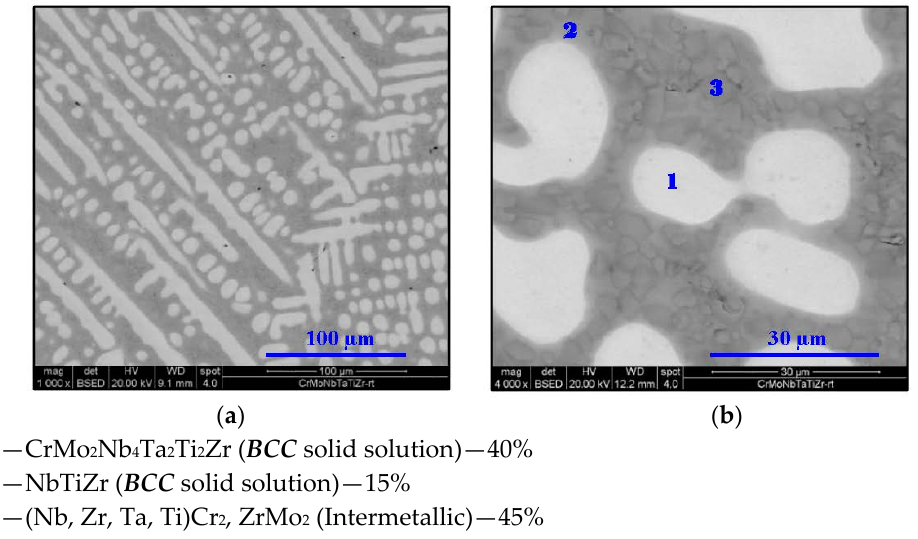
Figure 3 . SEM micrograph of Cr 20 Mo 10 Nb 20 Ta 10 Ti 20 Zr 20 at 25 °C at ( a ) 1000× and ( b ) 4000× magnifications Figure 3. SEM micrograph of Cr 20 Mo 10 Nb 20 Ta 10 Ti 20 Zr 20 at 25 ◦ C at ( a ) 1000 × and ( b ) 4000 × in BSE mode. magnifications in BSE mode. Materials 2018 , 11 , x FOR PEER REVIEW